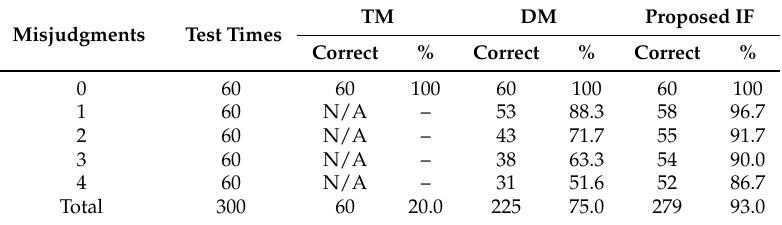
Table 5. Comparison of fault tolerance of three location